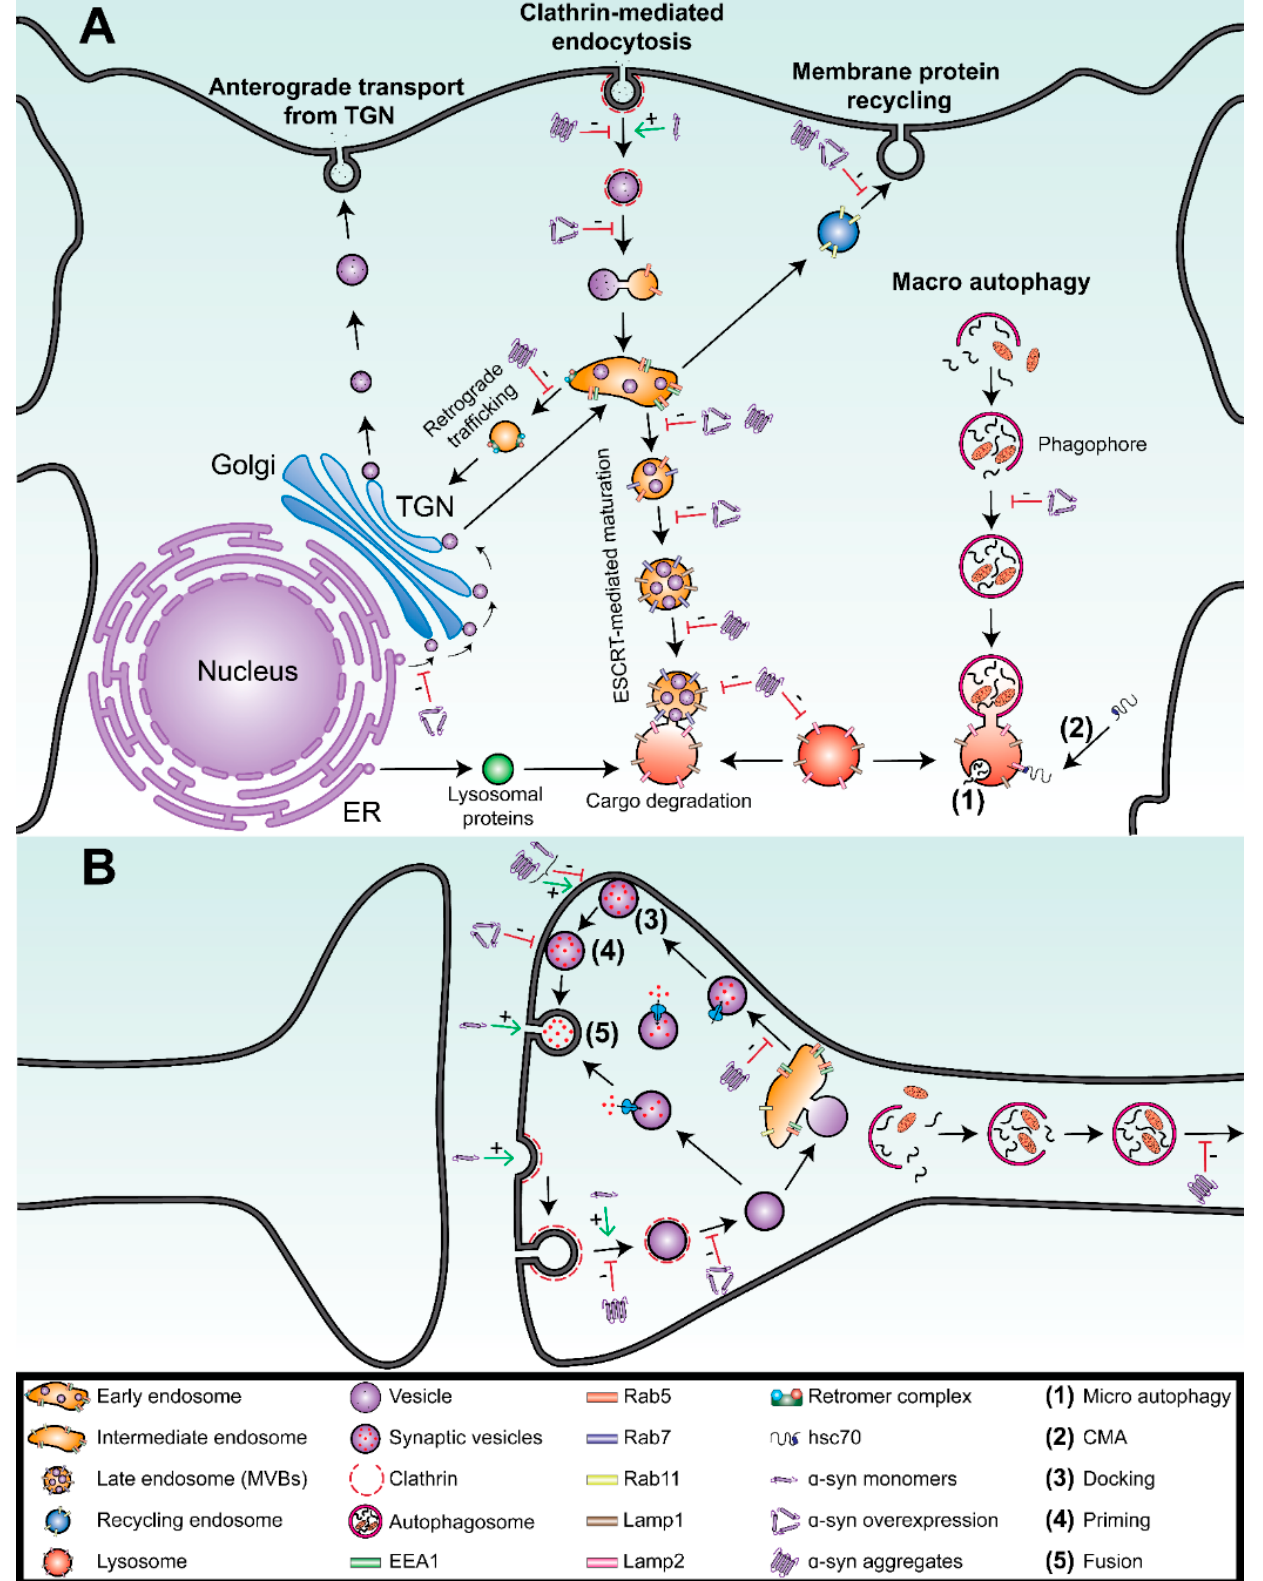
Figure 1. The complex relationship between alpha-synuclein and the endolysosomal system in Parkinson’s disease. ( A ) In the soma, essential functional proteins are produced in the endoplasmic reticulum (ER, purple) and are post-translationally modified in the Golgi apparatus (Golgi, blue). The overexpression of monomeric α‐ syn inhibits this trafficking process. Proteins, like lysosomal hydrolases, are packed into vesicles (purple) and delivered to the trans ‐ Golgi network (TGN,